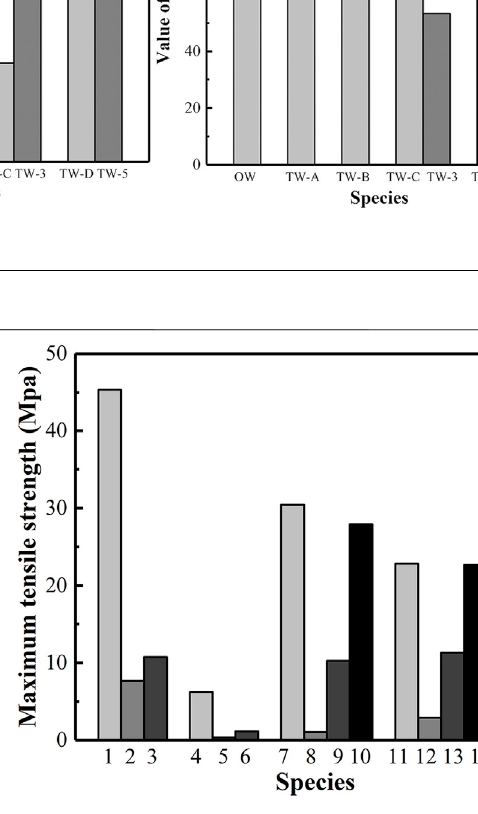
FIGURE 12 | The contact angle of logs and transparent samples over time. FIGURE 13 | Maximum tensile strength before and after treatment (1. A; 2. DW-A; 3. TW-A; 4. B; 5. DW-B; 6. TW-B; 7. C; 8. DW-C; 9. TW-C; 10. TW- 3; 11. D; 12. DW-D; 13. TW-D; 14. TW-5; 15.